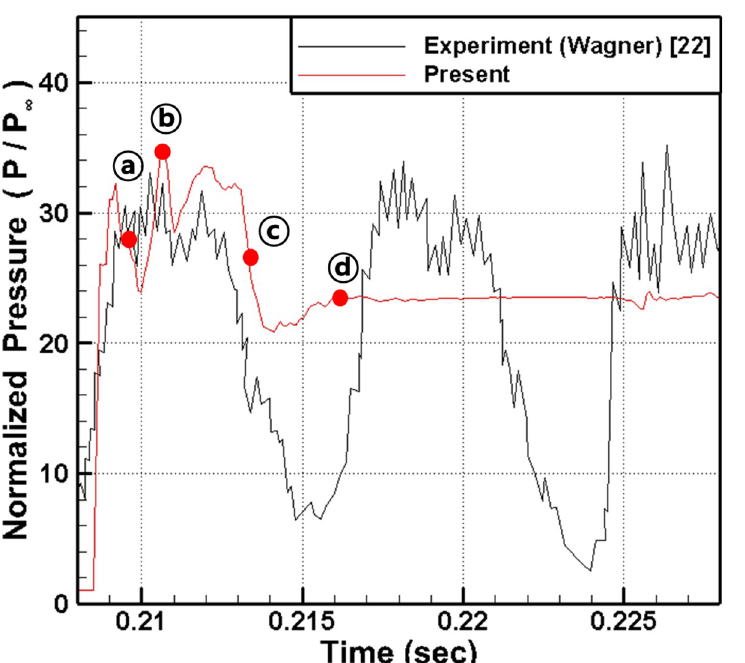
Fig 8. Comparison of pressure time history at x/h = 12.21 with experimental data.